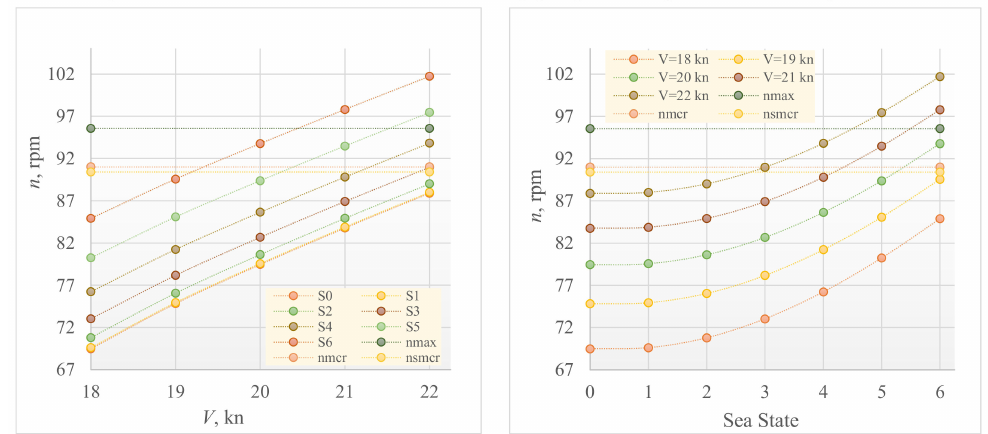
Figure 4. Propeller rate of revolution for different sailing speeds ( left ) and sea states ( right ).